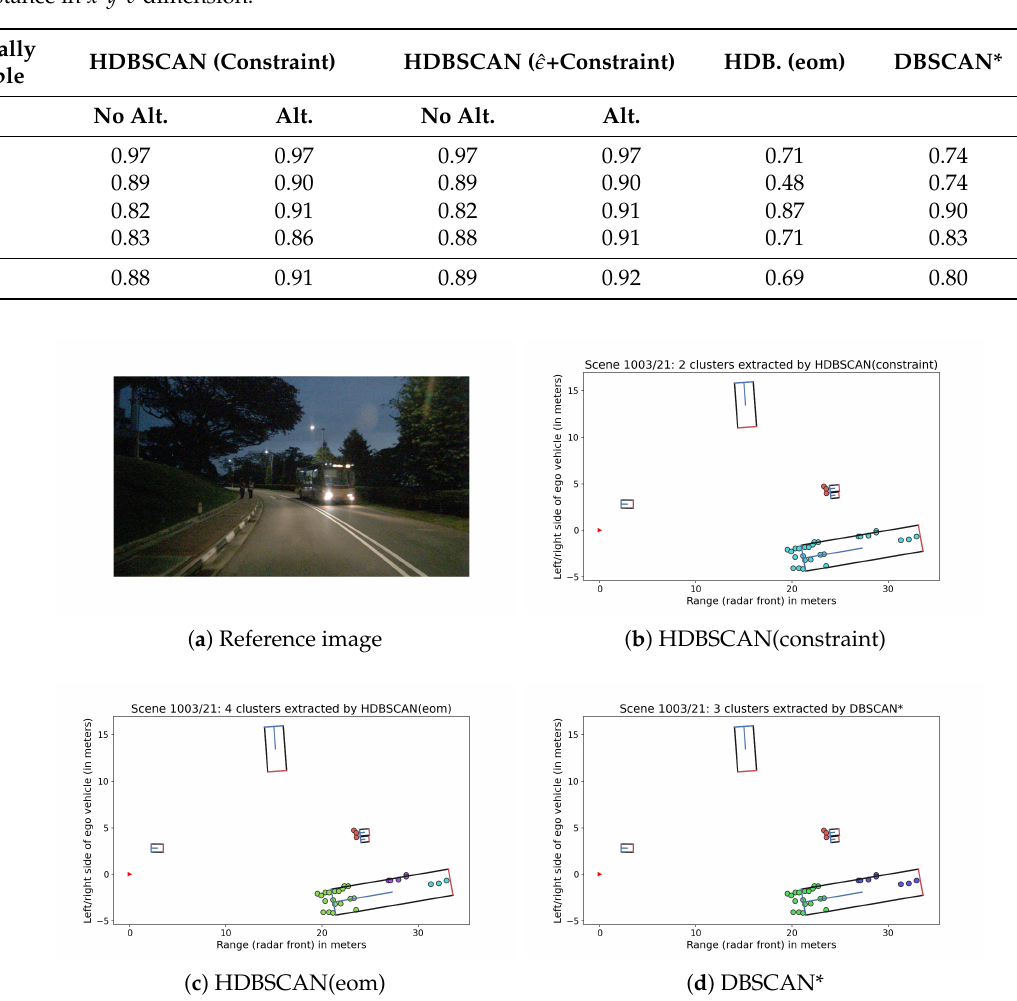
Table 2. Average ARI results for HDBSCAN(constraint) in comparison with other methods. HDBSCAN(ˆ (cid:101) +constraint) refers to a combined version with HDBSCAN(ˆ (cid:101) ). Both versions were tested with (Alt.) and without (No Alt.) the option of choosing a better alternative from the hierarchy level below. HDB. (eom) refers to default unsupervised HDBSCAN. “Theoretically achievable” refers to the best HDBSCAN cluster selection possible w.r.t. the given hierarchy. All methods are based on Euclidean distance in x - y - v dimension.